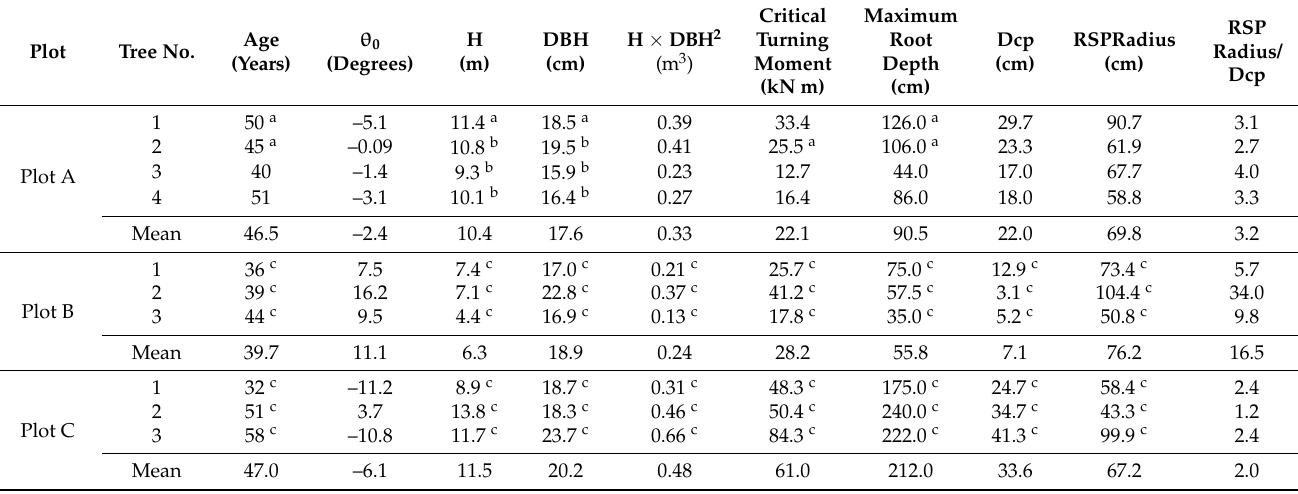
Table 1. Above- and below-ground traits of ten Pinus thunbergii